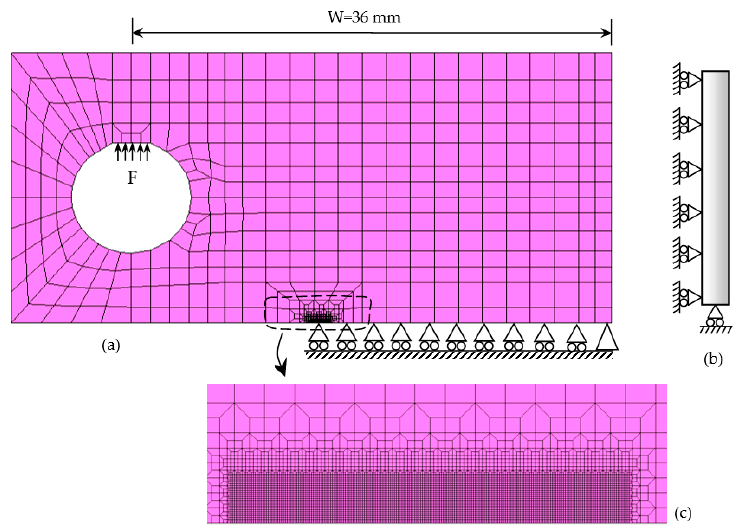
Figure 5. Model of the C(T) specimen. ( a ) Load and boundary conditions. ( b ) Boundary conditions for plane stress state. ( c ) Detail of finite element mesh.